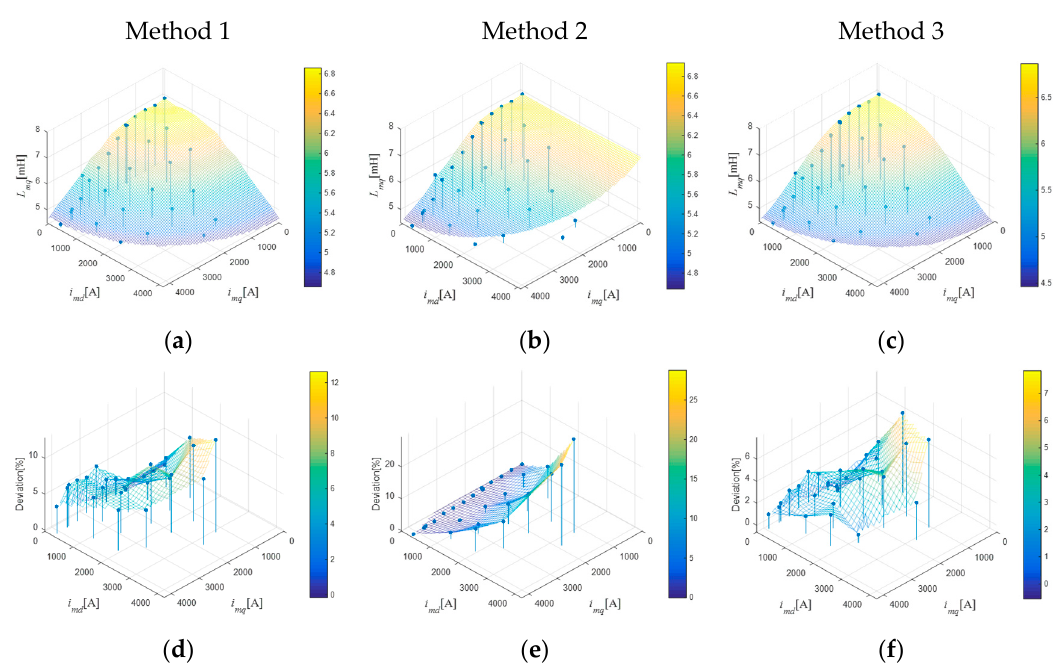
Figure 10. Comparison between the obtained experimental and analytical results with correspond- ing deviations for the d -axis magnetizing inductance: ( a , d ) Method 1 (Levi); ( b , e ) Method 2 (Kauko- nen); ( c , f ) Method 3 (El-Serafi & Wu).